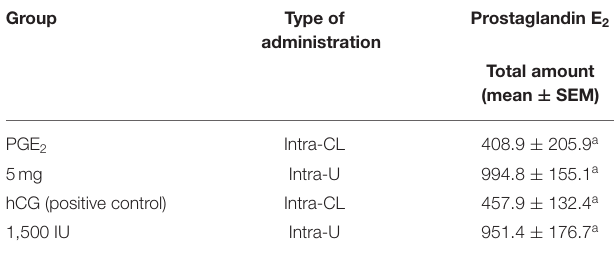
TABLE 4 | The effect of one intra-CL injection or one intrauterine administration of prostaglandin (PG) E 2 or human chorionic gonadotropin (hCG; positive control) on PGE 2 concentrations in mares’ blood plasma samples ( n = 6 per group) at day 10 of the estrous cycle.